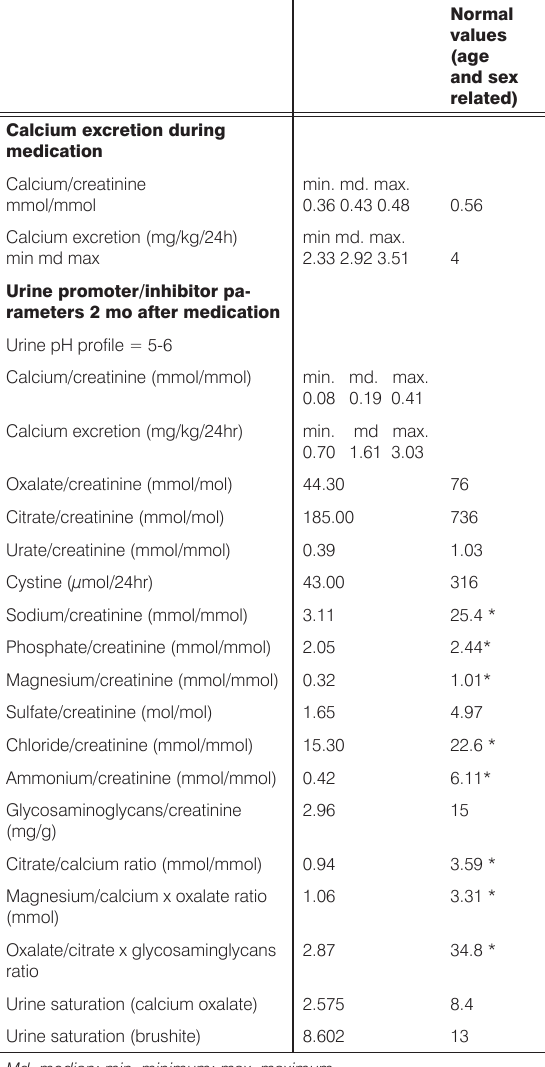
Table 1. Urinary calcium excretion during treatment and promoter/ inhibitor individual parameters, ratios and urine saturation 2 months after medication